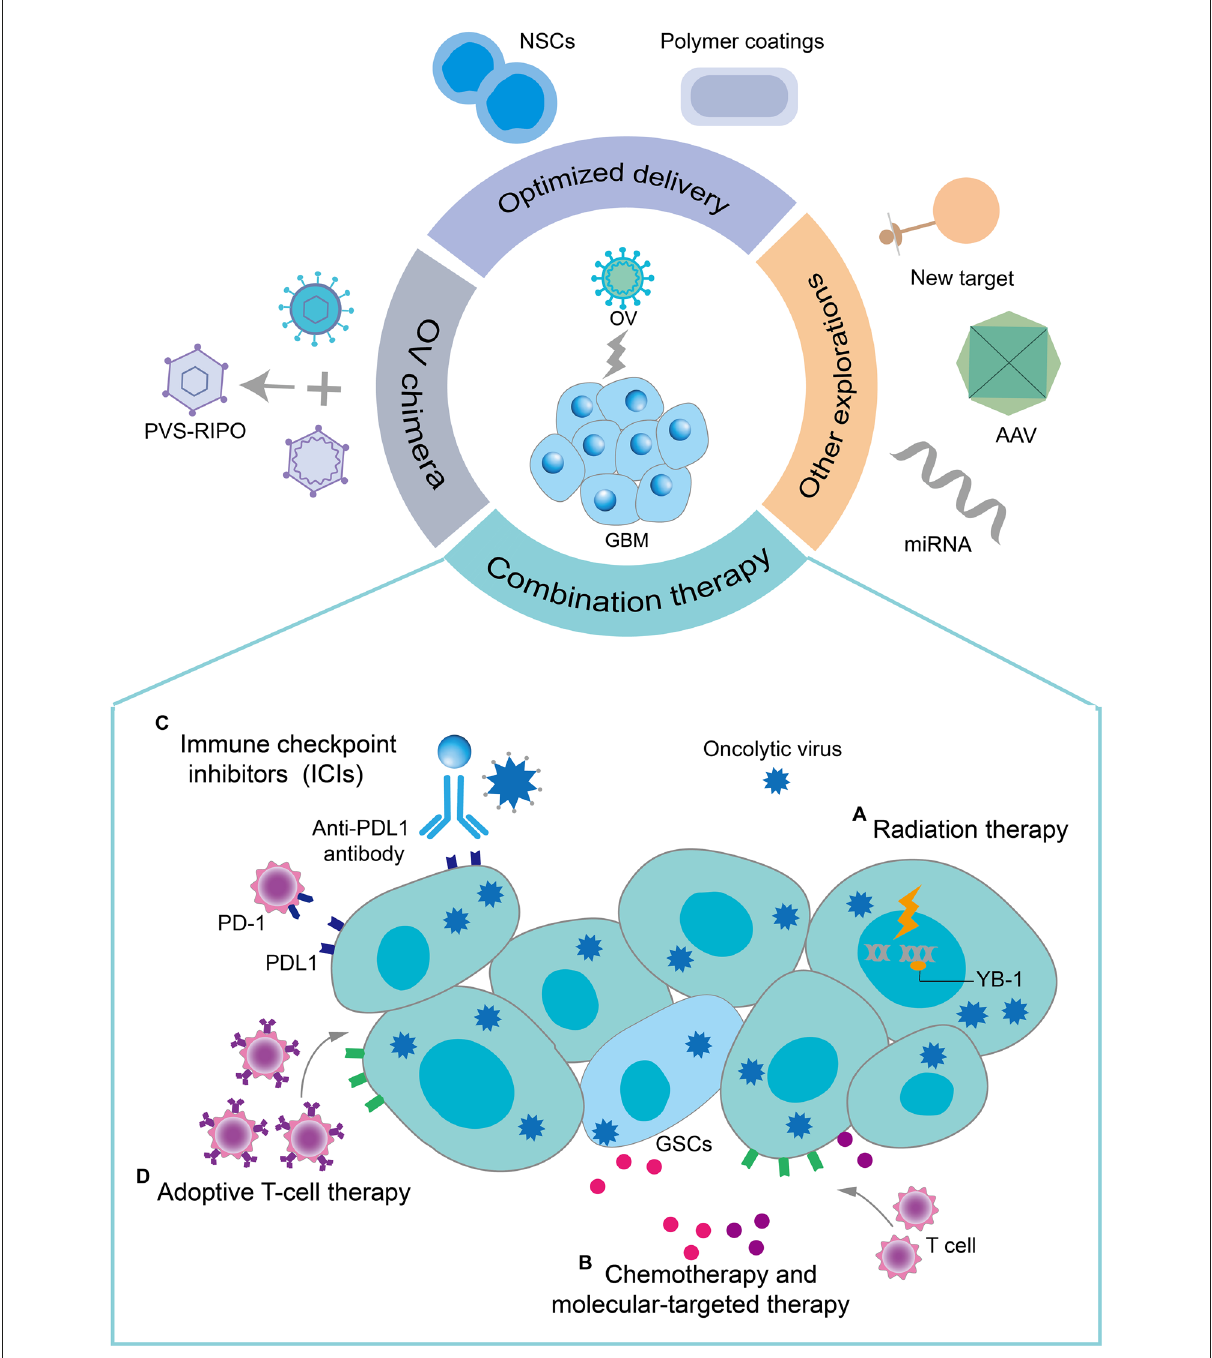
FIGURE4 Novel directions for oncolytic virotherapy of GBM. Combination therapy with oncolytic virotherapy, optimized delivery of OVs, OV chimeras, and some other explorations provide promising therapeutic options for oncolytic virotherapy for GBM. Some common combination therapy strategies are described here. (A) OVs sensitize infected GBM cells to radiation therapy by preventing their DNA damage repair. RT can enhance the replication of OVs in tumor cells by modifying the gene expression in drug-resistant tumor cells. (B) Chemotherapy and some molecularly targeted drugs have immunomodulatory effects, which together with oncolytic virotherapy could exert a synergistic antitumor immune effect. In addition, OVs selectively induced apoptosis of TMZ-resistant GSCs by regulating the apoptosis-related signaling pathways and DNA-damage response pathways. (C) The upregulation of PD-1 on T cells and PD-L1 on tumor cells induced by OVs infection increased the sensitivity of GBM to immune checkpoint inhibitors (ICIs). OVs improve the effectiveness of ICIs in GBM with low T-cell infiltration by recruiting T cells and inducing an antitumor T-cell response. (D) The increased expression of MHC class I molecules, cell-derived damage-associated molecular patterns (DAMPs), and cytokine release resulting from OV infection enhanced the recruitment and activity of adoptive T cells to